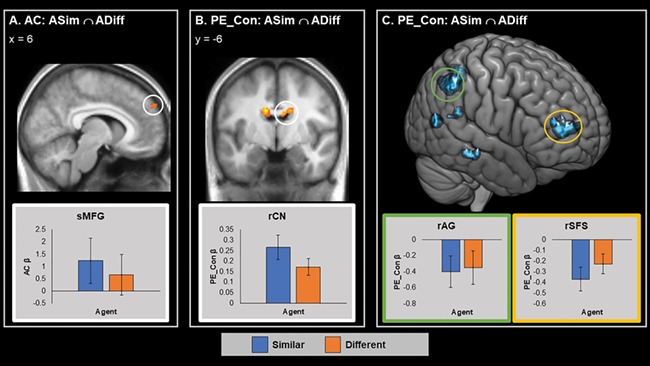
Brain areas showing significant cluster corrected tracking of AC and PE_Con for the Outcome screen. A. Areas significantly tracking AC in the positive ASim ∩ ADiff conjunction. B. Areas significantly tracking PE_Con in the positive ASim ∩ ADiff conjunction. C. Areas significantly tracking PE_Con in the negative ASim ∩ ADiff conjunction. Parameter estimates averaged across whole cluster. Error bars represent SEM. Graph border colours indicate matching circled area. Red/yellow represents positive activations and blue/green represents negative activations. sMFG = superior medial frontal gyrus, rCN = right caudate nucleus, rAG = right AG, rSFS = right superior frontal sulcus.